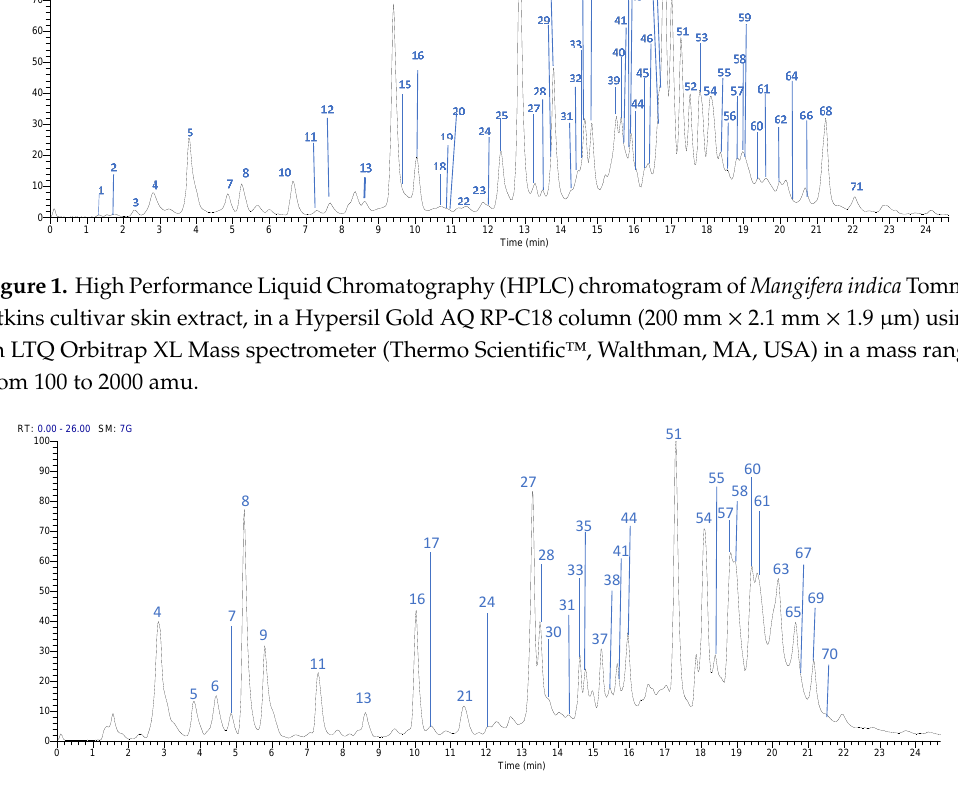
Figure 2. High Performance Liquid Chromatography (HPLC) chromatogram of Mangifera indica Keitt flesh extract in a Hypersil Gold AQ RP-C18 column (200 mm × 2.1 mm × 1.9 µm) using an LTQ Orbitrap XL mass spectrometer (Thermo Scientific™, Walthman, MA, USA) in a mass range from 100 to 2000 amu.